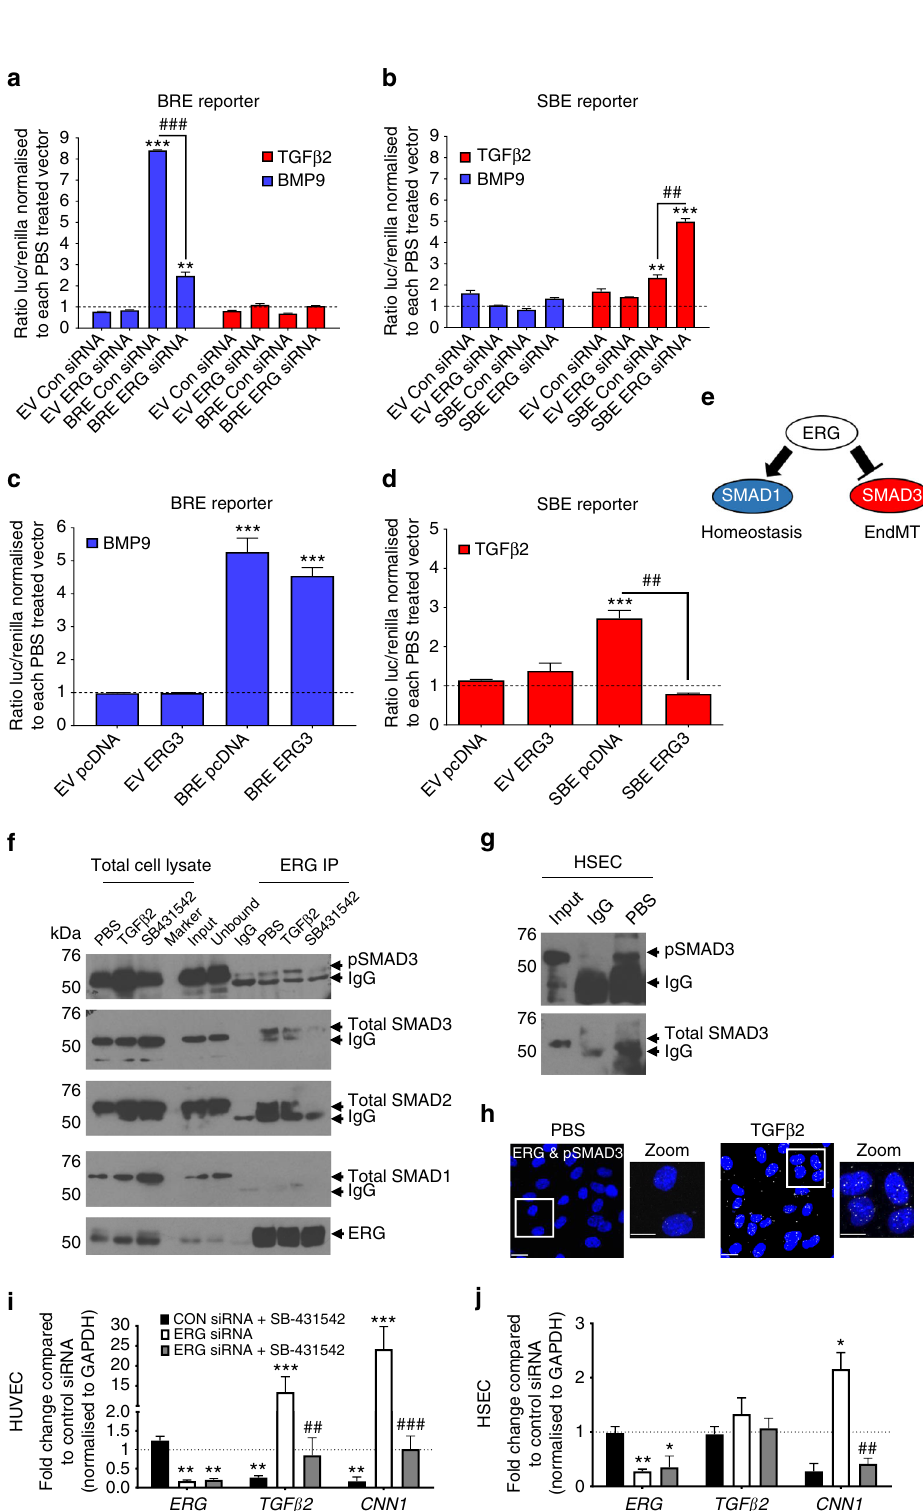
SMAD3 activity (Fig. 6e) by co-administration of the TNF- α antagonist etanercept in an acute CCL 4 -induced liver injury. A single CCL 4 injection caused a signi fi cant increase in SMA (Fig. 6f), reduction of ERG expression (Fig. 6g) and enhanced phosphorylation of SMAD3 at 48 h (Fig. 6h and Supplementary Fig. 9B); co-administration of etanercept signi fi cantly